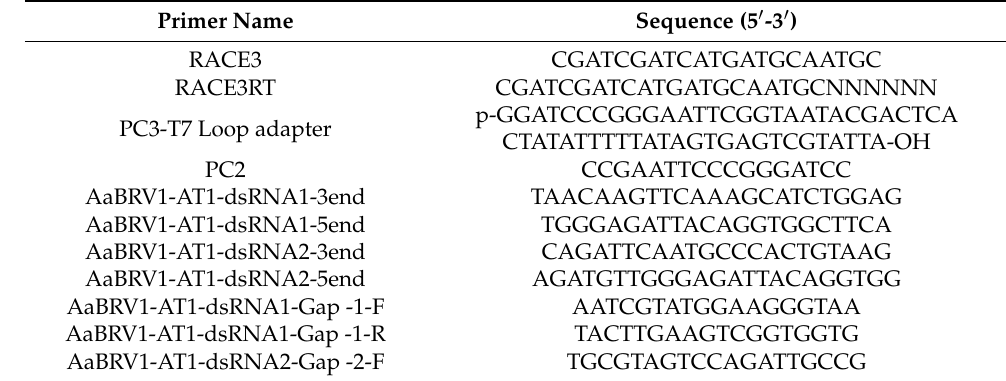
Table 1. Primers used to determine the complete genome sequence of the mycovirus Alternaria alternata botybirnavirus 1-AT1 (AaBRV1-AT1) in this study. Primer